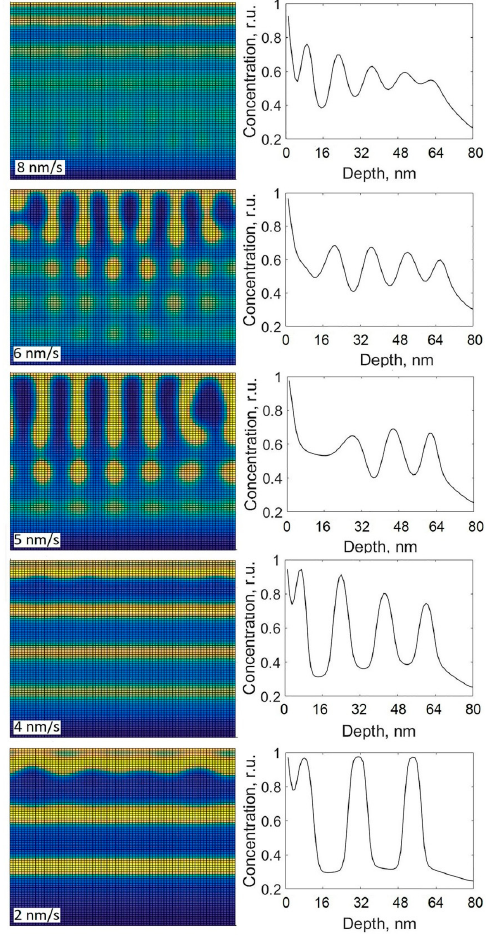
Figure 8. Cross-sectional views and depth profiles of carbon obtained by the modified model using different growth rates.